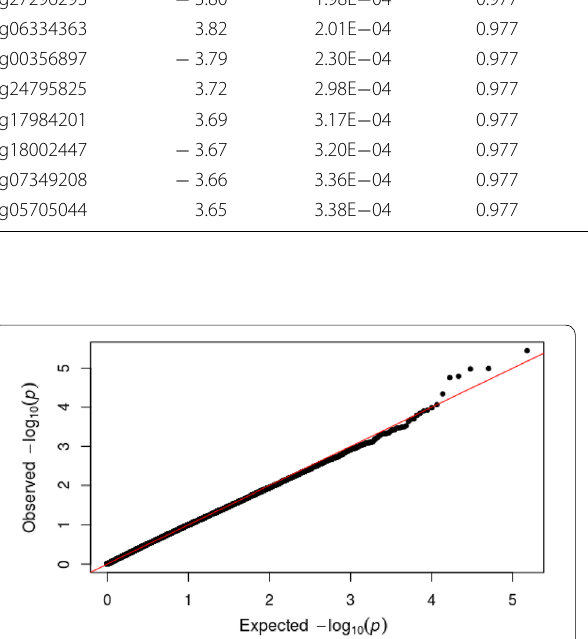
Fig. 4 QQ plot. The plot shows no evidence for inflation or bias in the association analysis of DNA methylation with total LEQ scores (Lambda =